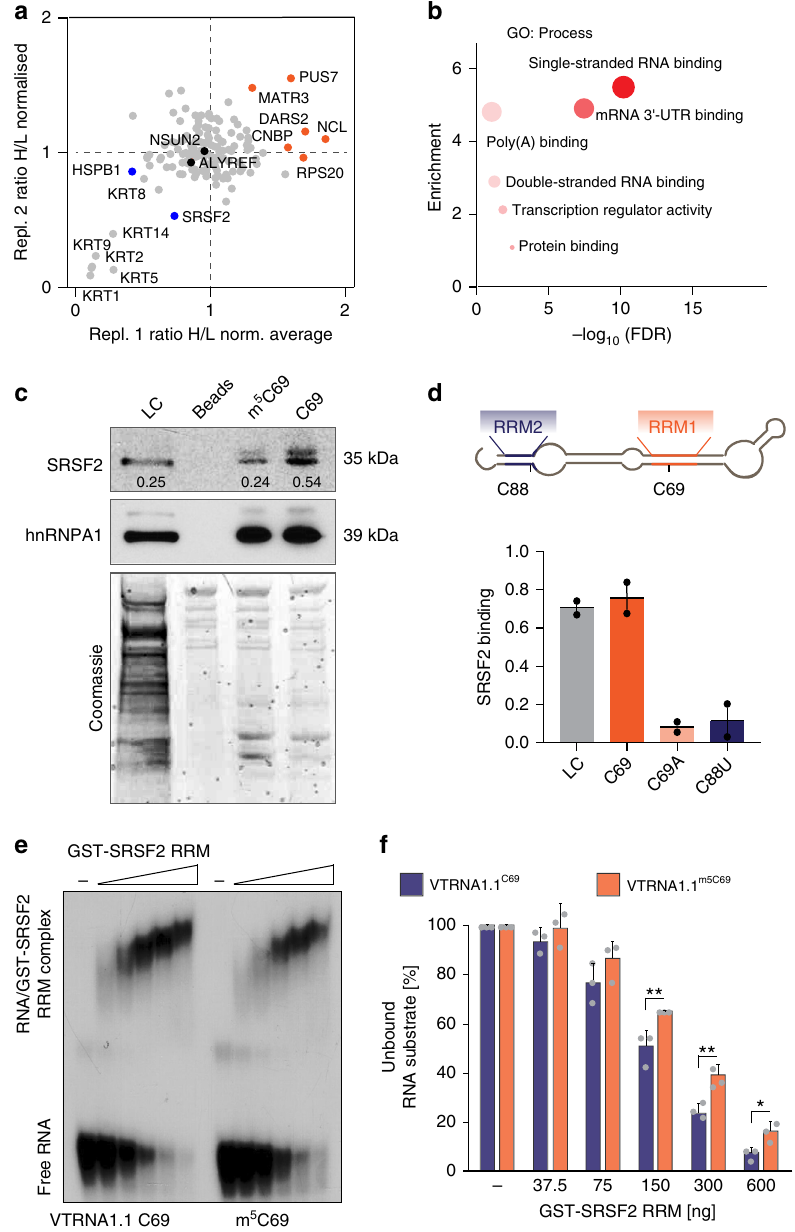
Fig. 2 SRSF2 preferentially binds un-methylated human VTRNA1.1. a Of the 144 common proteins binding to VTRNA1.1 in two different RP-SMS experiments, a small number bound methylated (red) or unmethylated (blue) VTRNA1.1 with higher af fi nity. b Gene Ontology (GO) analyses of the 144 commonly bound proteins. c Western blot and Coomassie stain for SRSF2 in HeLa cell lysates pulled-down with agarose beads coupled to